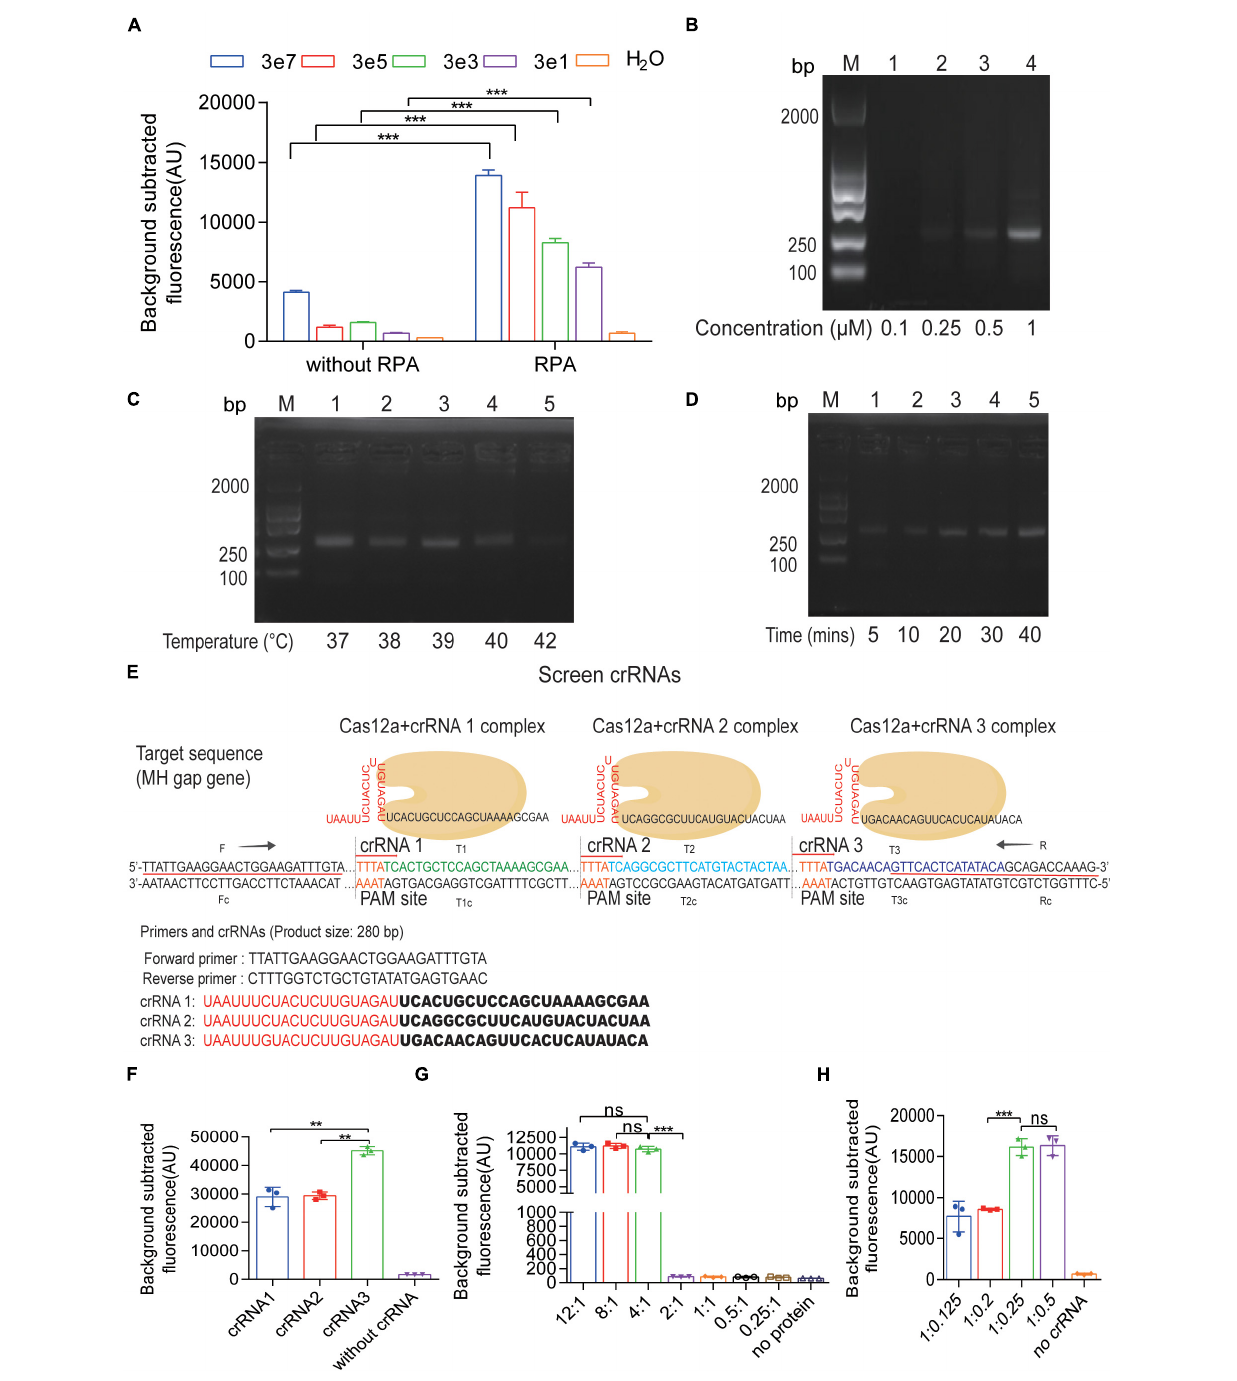
Frontiers in Microbiology |